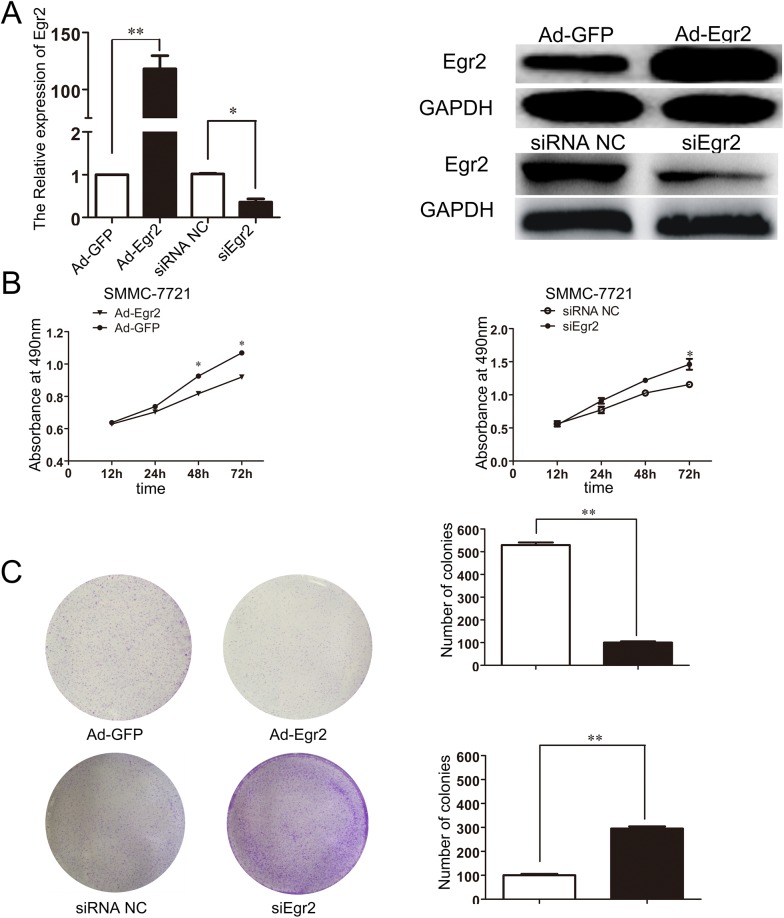
Egr2 Suppressed HCC cell proliferation in vitro.(A) Relative mRNA and protein expressions of Egr2 in Ad-Egr2 or siEgr2 transfected SMMC7721 cells. (B) Proliferations of SMMC7721 transfected with Ad-Egr2 or siEgr2 were testified by MTS. (C) Proliferations of SMMC7721 transfected with Ad-Egr2 or siEgr2 were examined by colony formation assay. *P<0.05, **P<0.01.